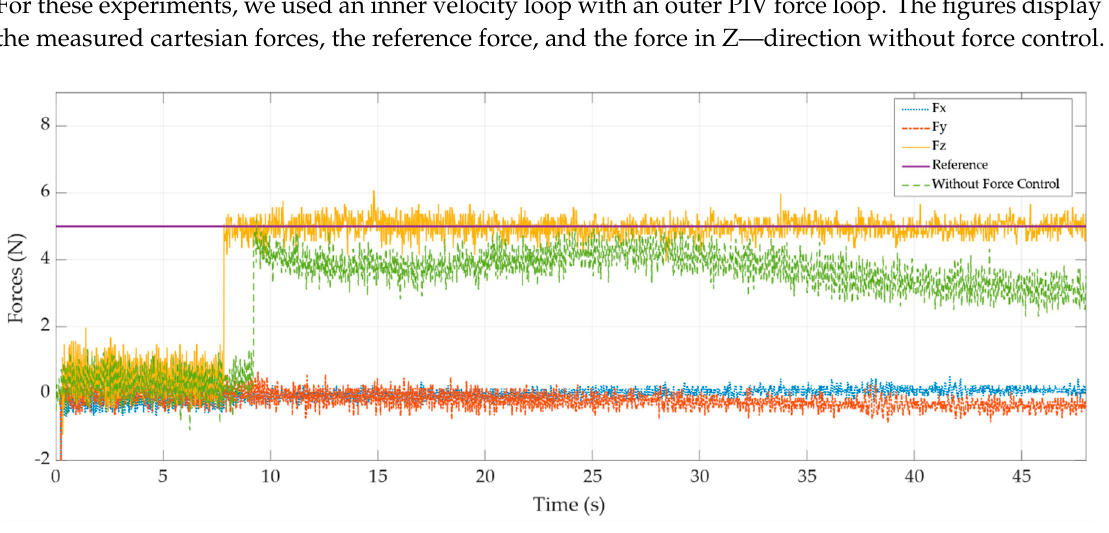
Figure 11. Polishing with force control with reference force 5 N.